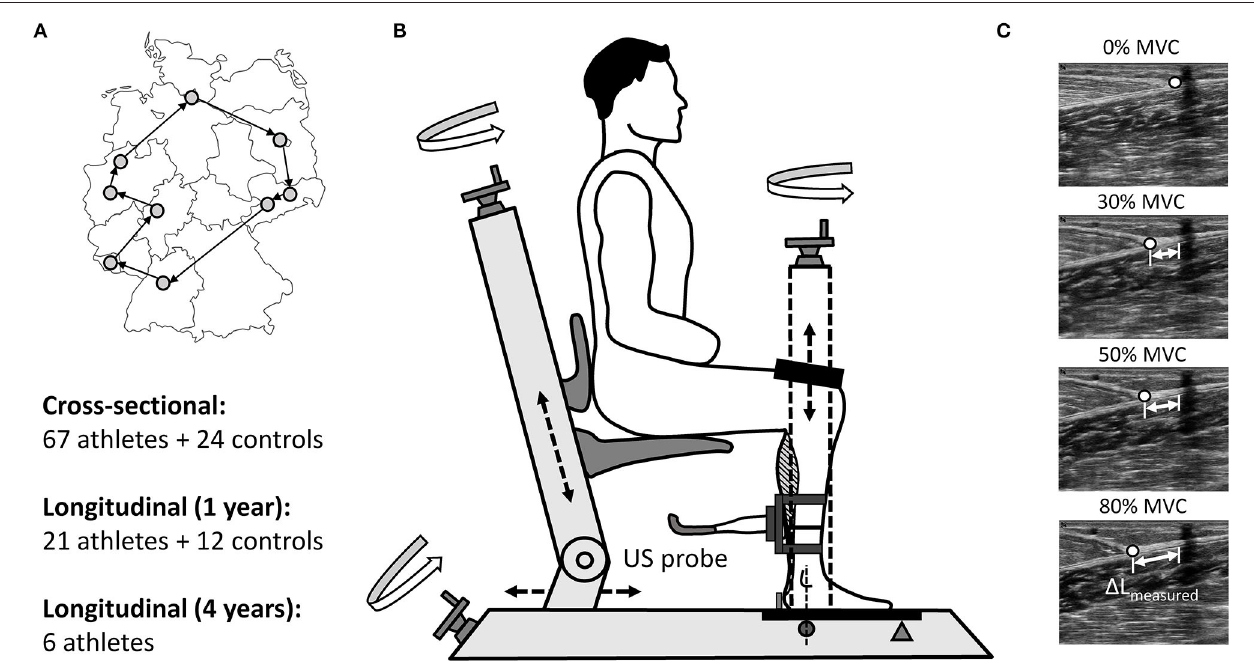
FIGURE 1 | Measurement locations at the Olympic training centers in Germany incl. study design (A) and the used custom-made analysis device (TEMULAB ® , Protendon GmbH & Co. KG, Aachen, Germany) to assess TS MTU mechanical properties incorporating dynamometry and ultrasonography (B) . In order to determine the force-elongation relationship of the tendon the displacement of the myotendinous junction (MTJ) of the m. gastrocnemius medialis ( 1 L measured ) was digitized at rest (0%) and at three sustained contractions (target joint moment constantly held for 3s) at fixed target ankle joint moment levels (30, 50, and 80%; C